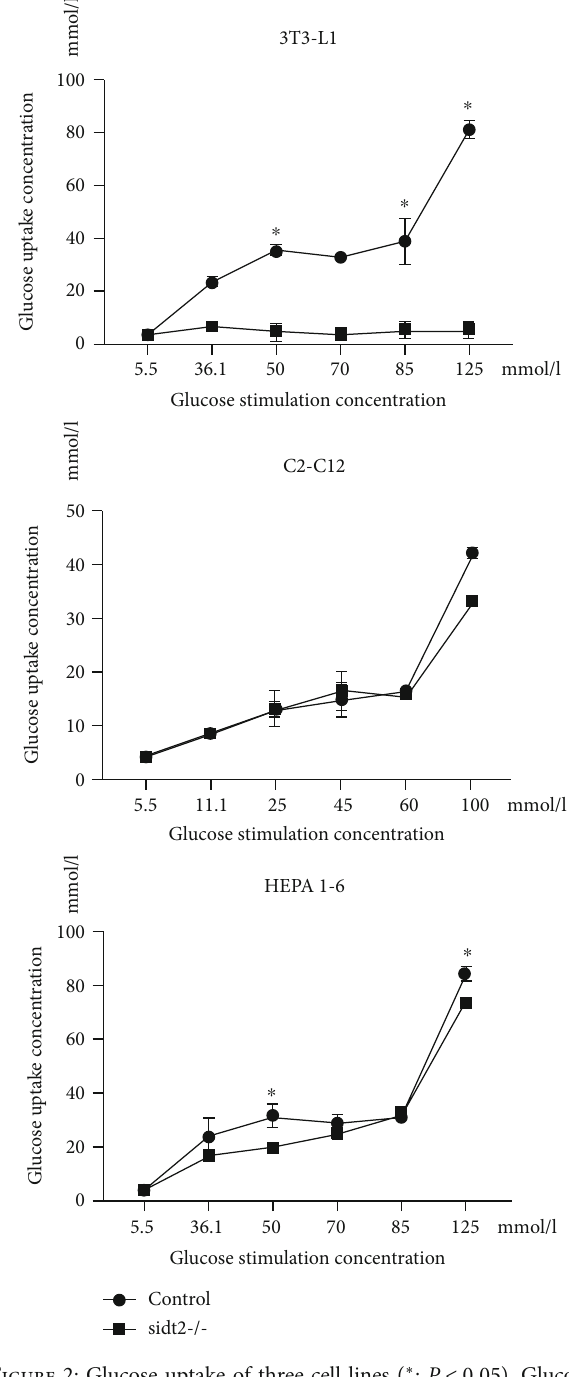
Figure 2: Glucose uptake of three cell lines ( ∗ : P < 0 : 05 ). Glucose uptake in the sidt2 knockout group was lower than that in the control group, and the di ff erence was signi fi cant at some